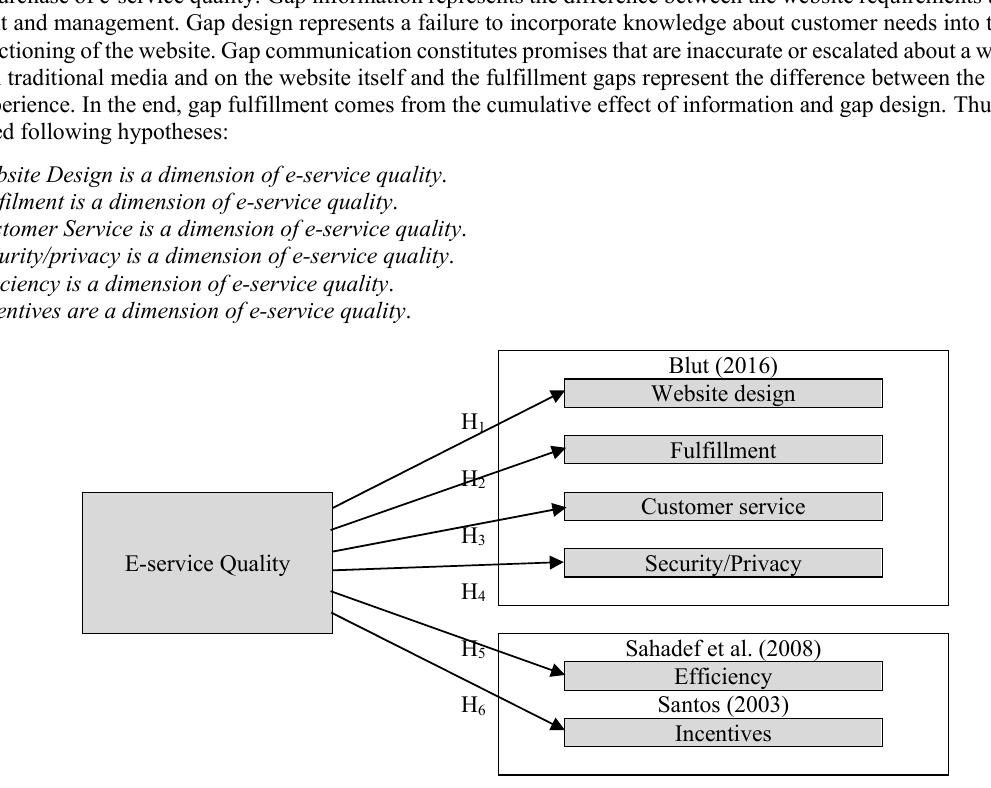
Fig. 1. Research model for analyzing the effect of E-Service